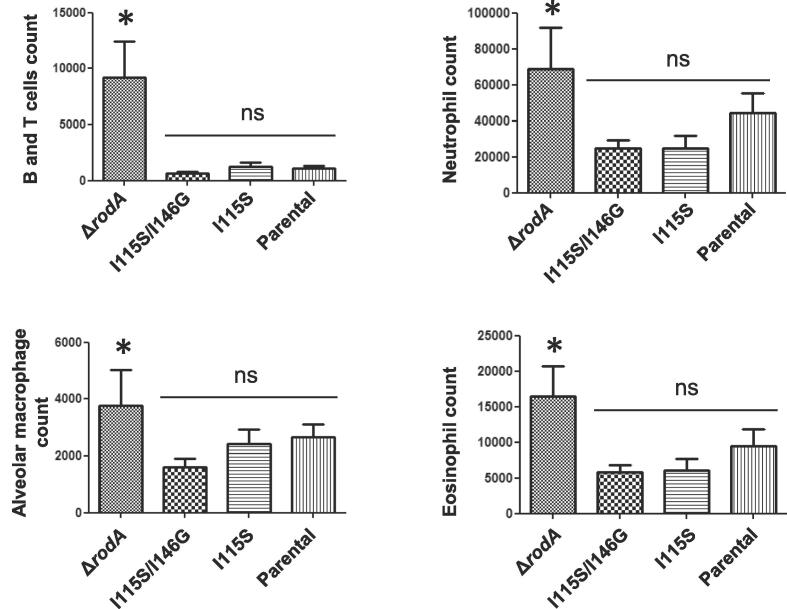
Recruitment of cells in the lungs of C57/Bl6 mice after inhalation of conidia of the single RodA I115S, double RodA I115S/I146G, ΔrodA mutant and the parental strain Ku80. Total number of cells were counted in the BALs (counts from >6 mice per experiment, 2 experiments) 6 h after conidial inoculation and were expressed as average with SEM. No significative differences were observed between the two mutants and the parental strain, while more cells were significantly recruited in the lungs of mice infected with the ΔrodA mutant.